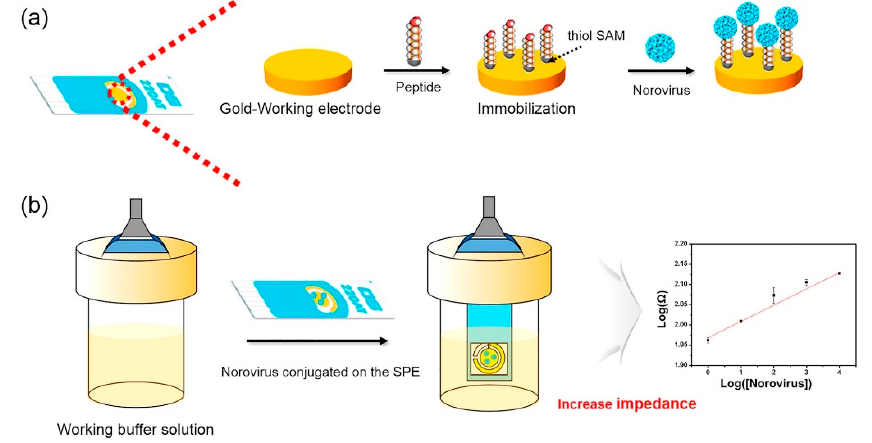
Figure 6. Schematic illustration for norovirus detection using an impedance electrochemical biosensor. ( a ) Peptides were immobilized as self-assembly monolayers (SAMs) on the gold-working electrode. ( b ) Working buffer solution can be used for oxidation and reduction. Dropped norovirus conjugated with the affinity peptide on the gold screen-printed electrode (SPE) and measured by electrochemical impedance spectroscopy. (Reproduced from Baek et al. [158] with permission from the publisher).